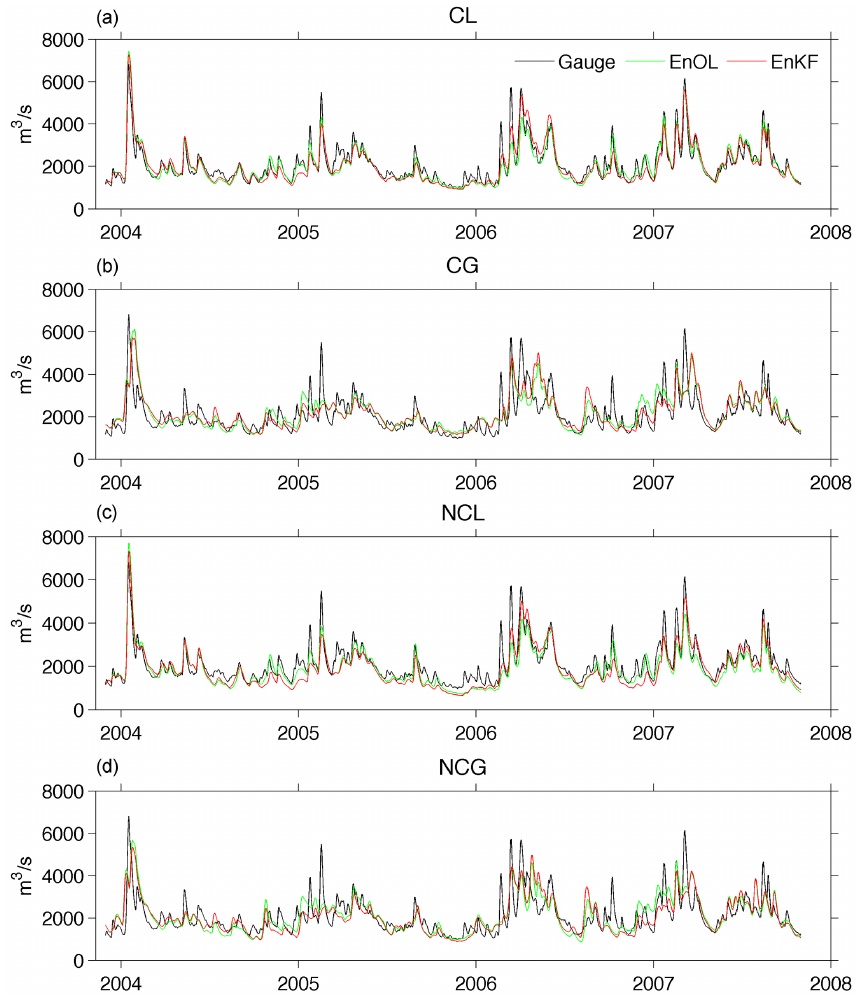
Figure 10. Estimated and observed streamflow at the Wesel gauge station in four different scenarios (CL: calibrated parameters with local forcing data; CG: calibrated parameters with global forcing data; NCL: non-calibrated parameters with local forcing data; NCG: non- calibrated parameters with global forcing